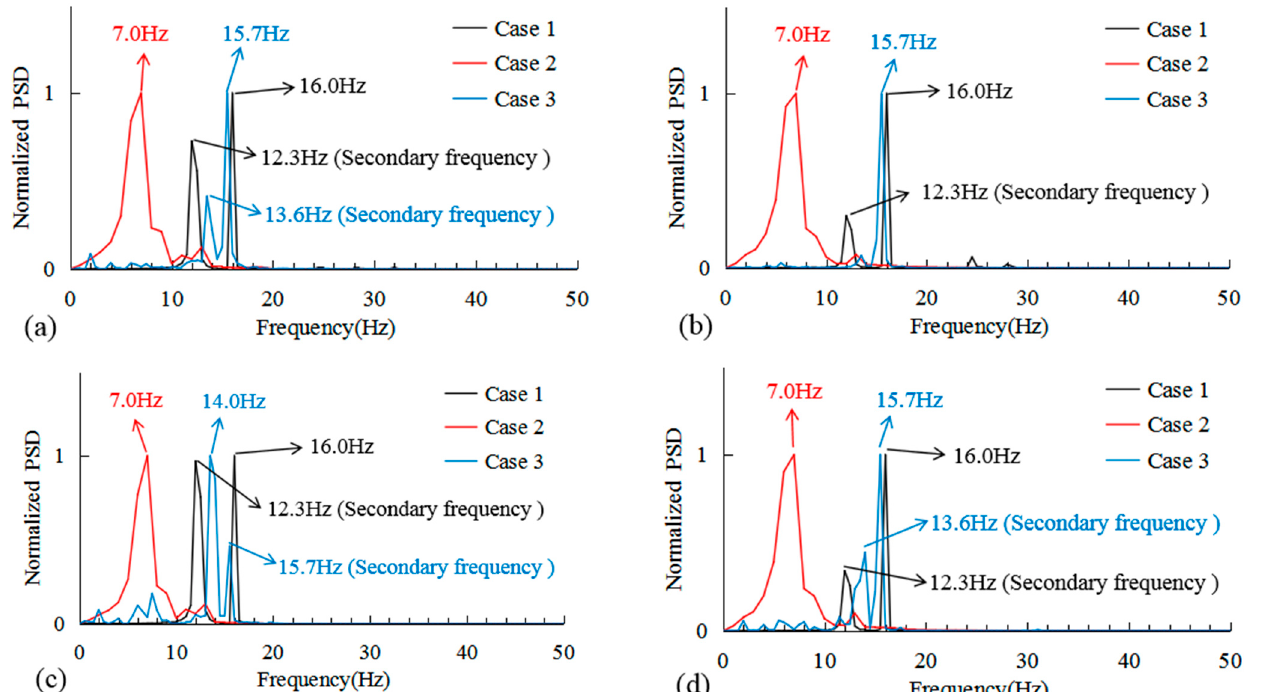
Figure 14. PSD in the vibration response stability stages: ( a ) d1, ( b ) d1, ( c ) d3, ( d ) d4.